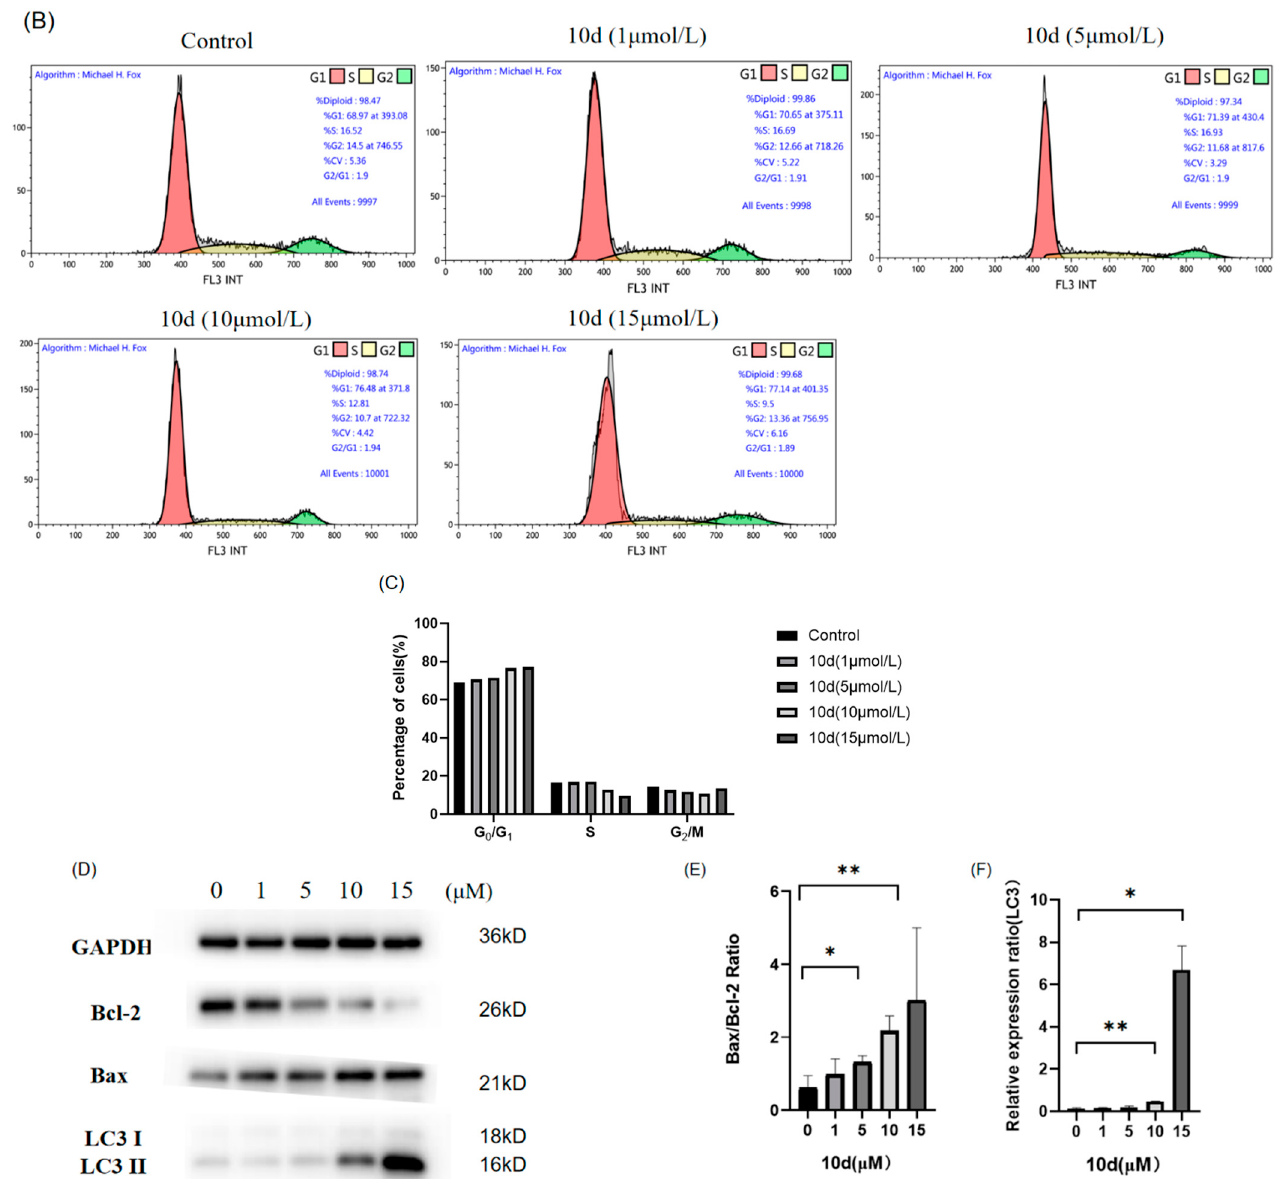
Figure 3 . Effects of compound 10d on cell apoptosis, cell cycle, and the expression of apoptotic and autophagic proteins. ( A , B ) Flow cytometry analysis of SMMC-7721 cells after treatment with compound 10d at different concentrations for 48 h. ( C ) Quantitative data analysis for the number of cells (% of total) in G 0 /G 1 , S, and G 2 /M phases for different treatment concentrations for 24 h. ( D ) Western blot analysis of Bcl-2, Bax, and LC3 protein expression levels in SMMC-7721 cell treated with compound 10d for different concentration for 48 h. ( E ) The Bax:Bcl-2 protein ratio in SMMC-7721 cells treated with different concentrations of compound 10d for 48 h.( F ) The relative expression rates of LC3 protein in SMMC-7721 cells treated with different concentrations of compound 10d for 48 h. Values are mean ± SD ( n = 3).* p < 0.05, ** p < 0.01.